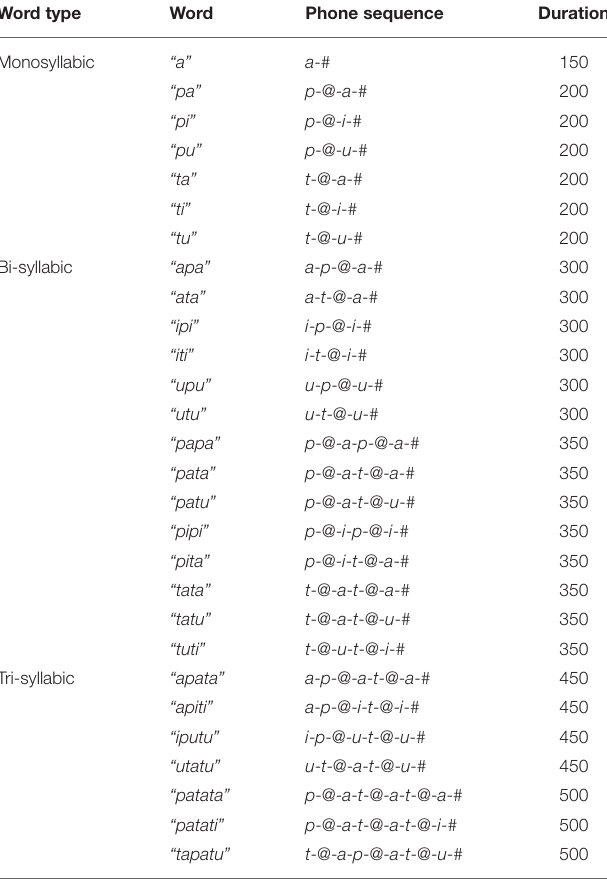
TABLE 2 | List of the 28 words of the lexicon together with their “phonetic” content. Word